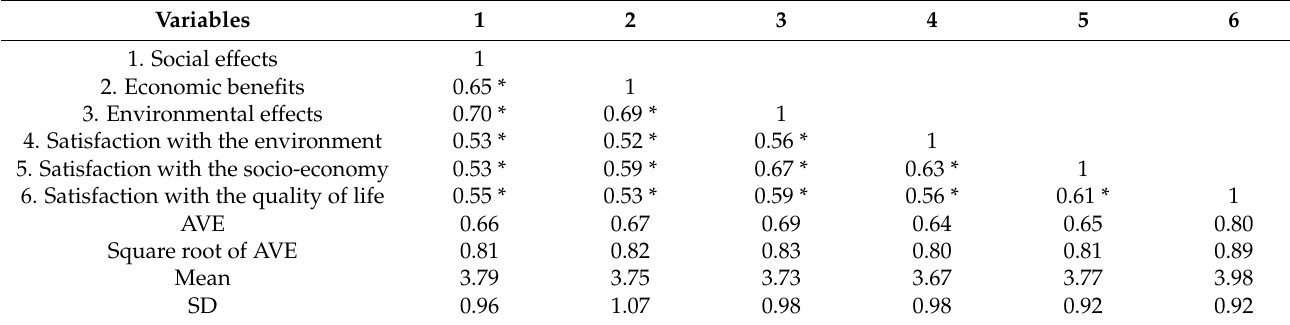
Table 3. A correlation matrix of the correlation between different